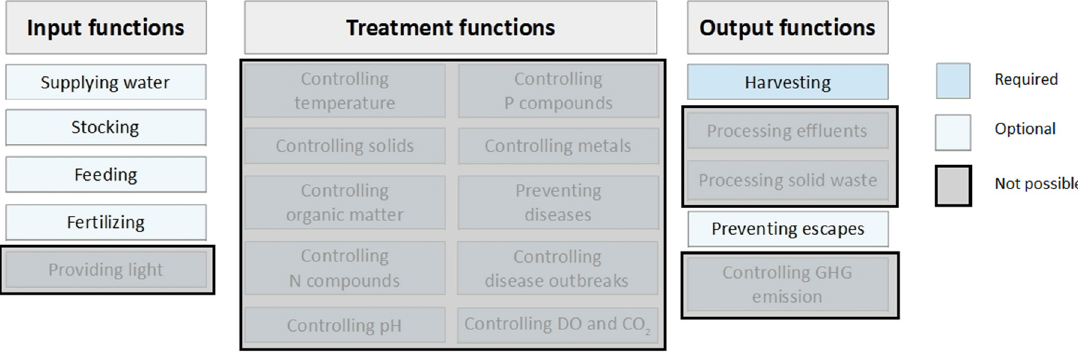
Figure 3. System map describing extensive aquaculture systems.